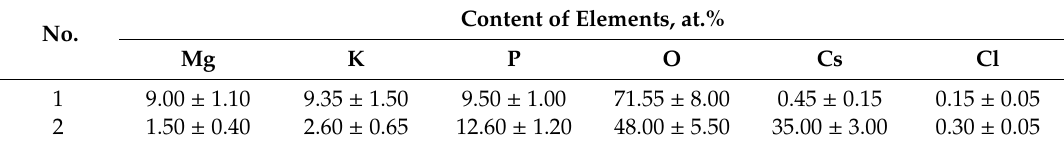
Figure 2. SEM image of the compound containing CsCl. Table 1. Average data of elemental composition of the compound containing CsCl.